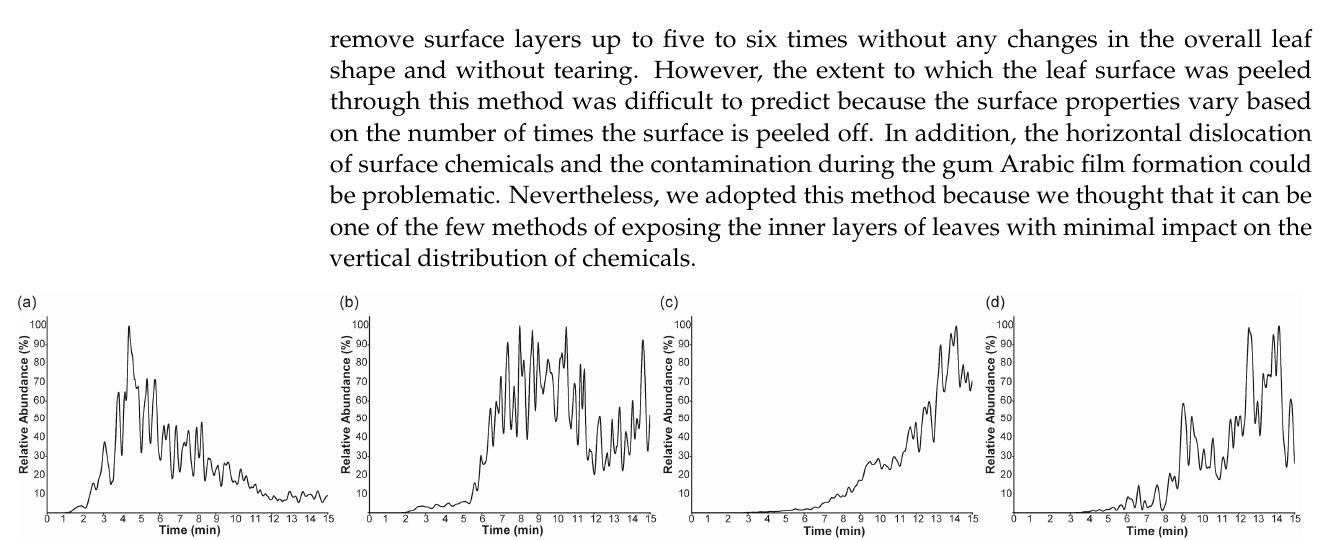
Figure 4. Selected ion monitoring (SIM) chronograms for the ions at ( a ) m / z 447, ( b ) m / z 535, ( c ) m / z 549, and ( d ) m / z 569, which were detected from a Hypericum leaf surface by nano-DESI MS. SIM experiments were performed with a mass window of ± 1 Da.